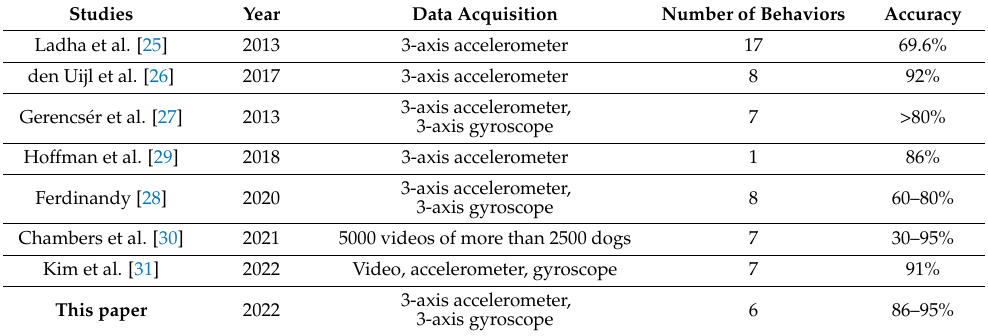
Table 4. Performance comparison with other studies